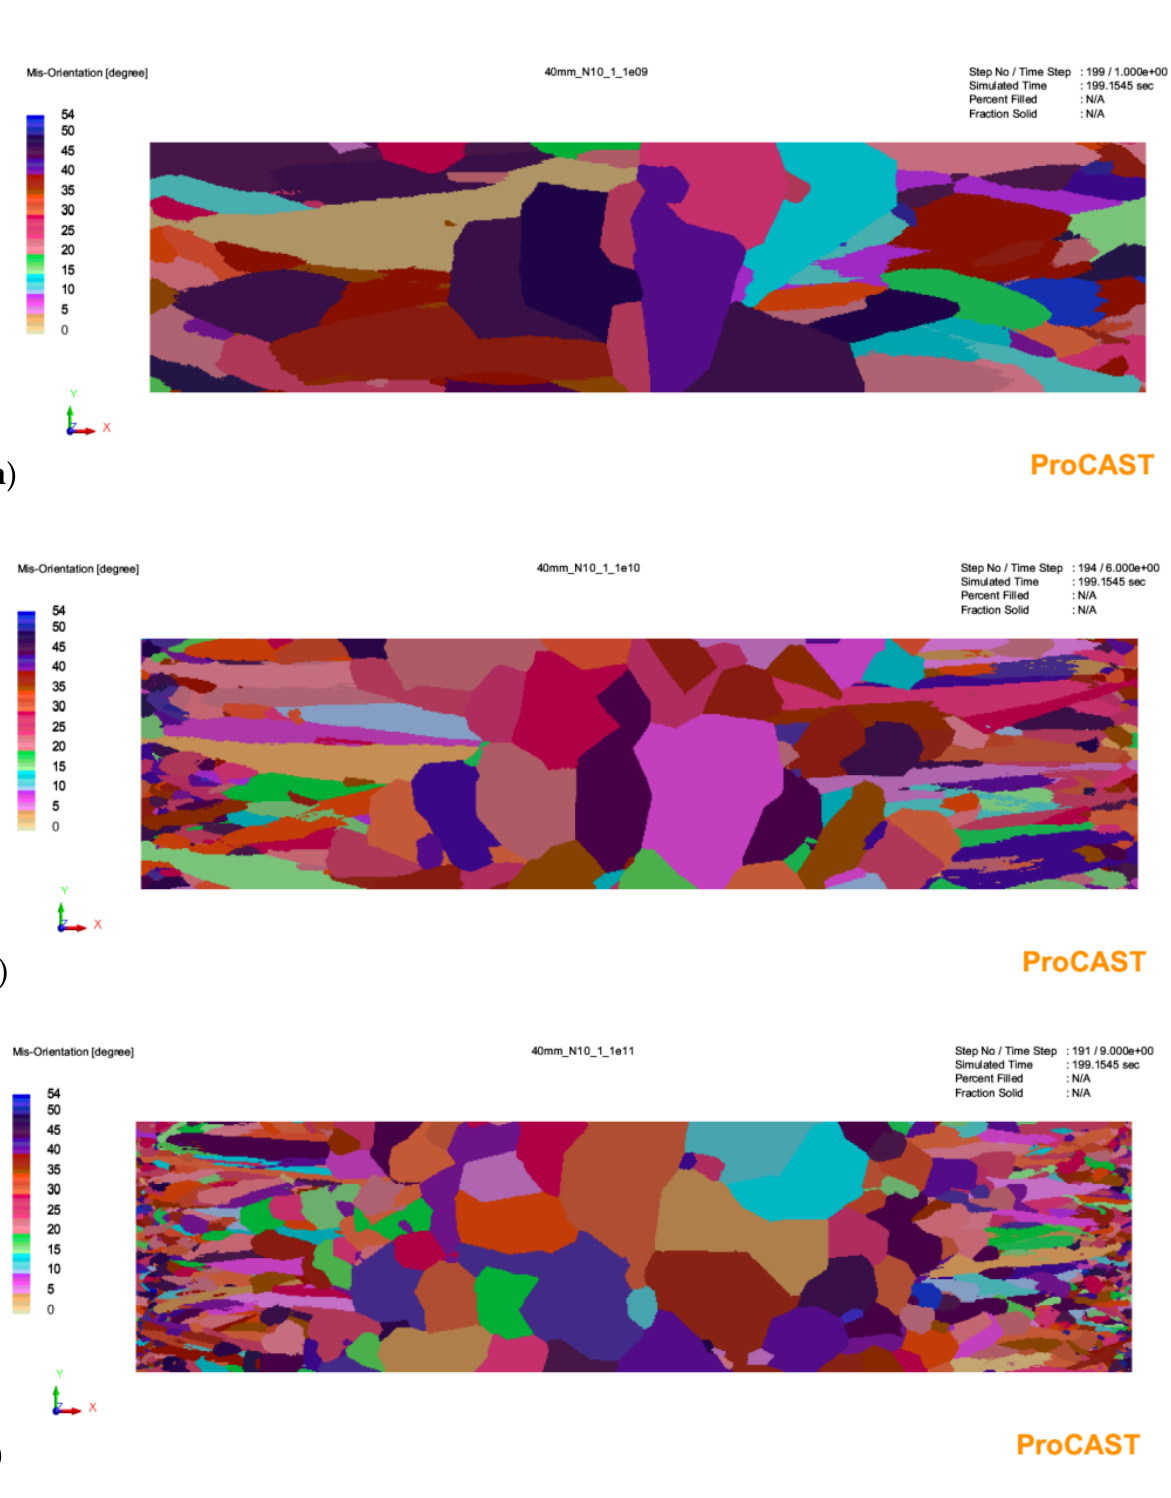
Figure 5. Simulation results for a casting wall thickness of 40 mm with a given number of austenite nucleation sites in the amount of: ( a )—10 9 ; ( b )—10 10 ; ( c )—10 11 .